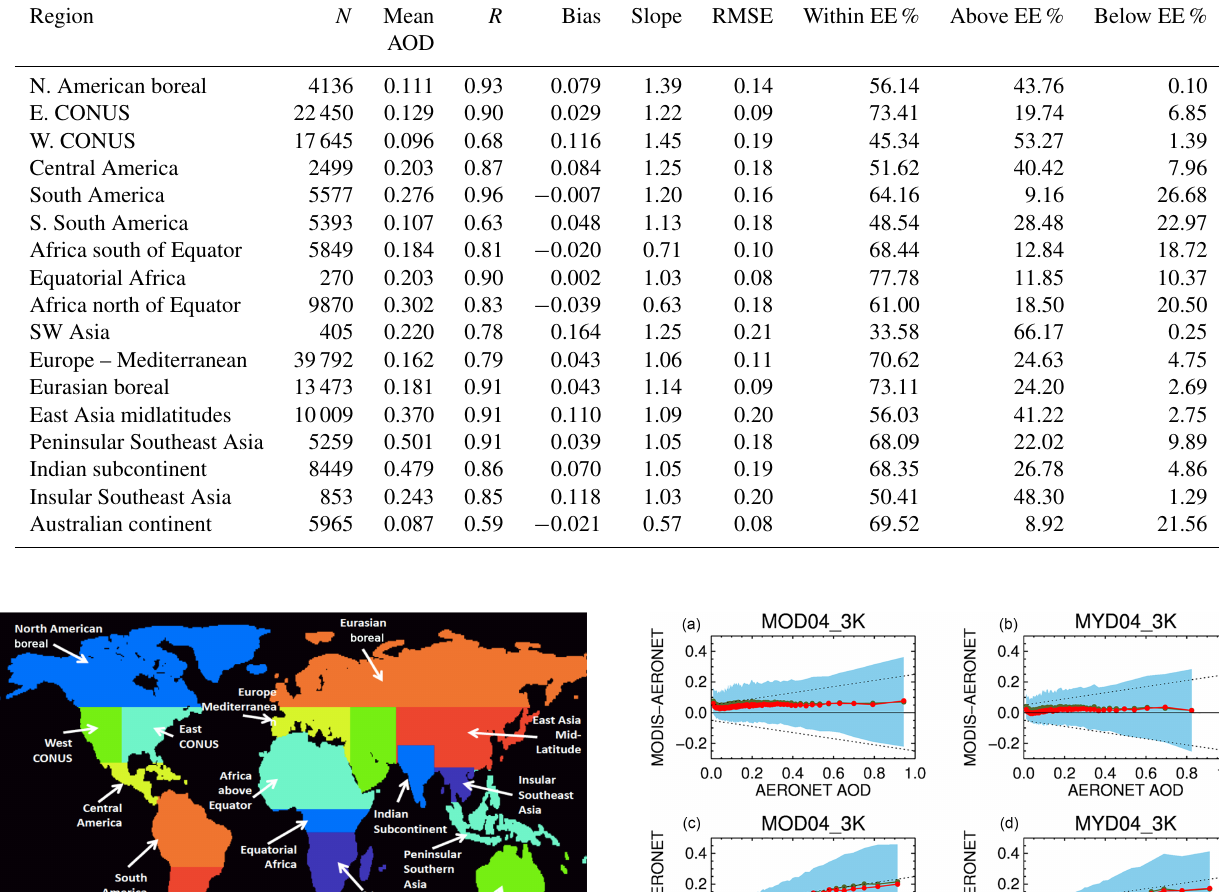
Table 2. Regional statistics of intercomparison between MODIS and AERONET. This is using joint data sets of Terra and Aqua for QAF = 3 only.